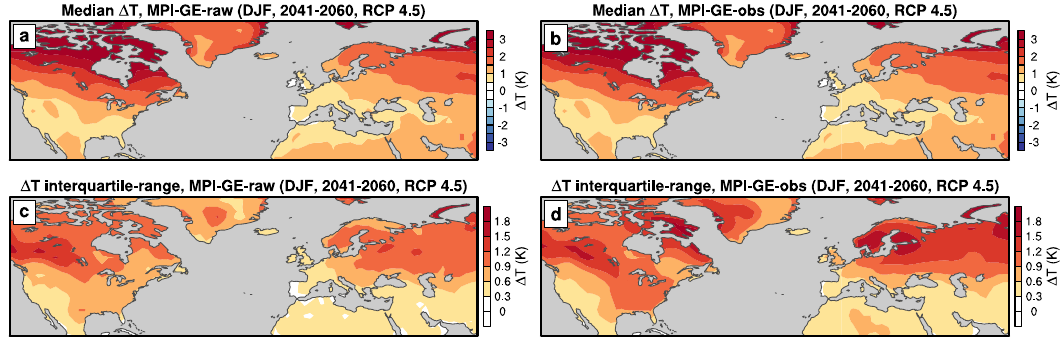
Fig. 2 Projection of mid-century climate change for boreal winter. a Median projection of the winter (DJF) surface-air temperature change in the period 2041 – 2060, with respect to the 1995 – 2014 baseline period, in the 99-member MPI-GE-raw ensemble (under the RCP 4.5 emissions scenario). b As is a but for the median of the synthetic 10,000-member MPI-GE-obs ensemble. c Interquartile range (i.e. 25 – 75% range) of the 2041 – 2060 winter surface-air temperature change in the 99-member MPI-GE-raw ensemble. d As is c but for the interquartile range of the synthetic 10,000-member MPI-GE-obs